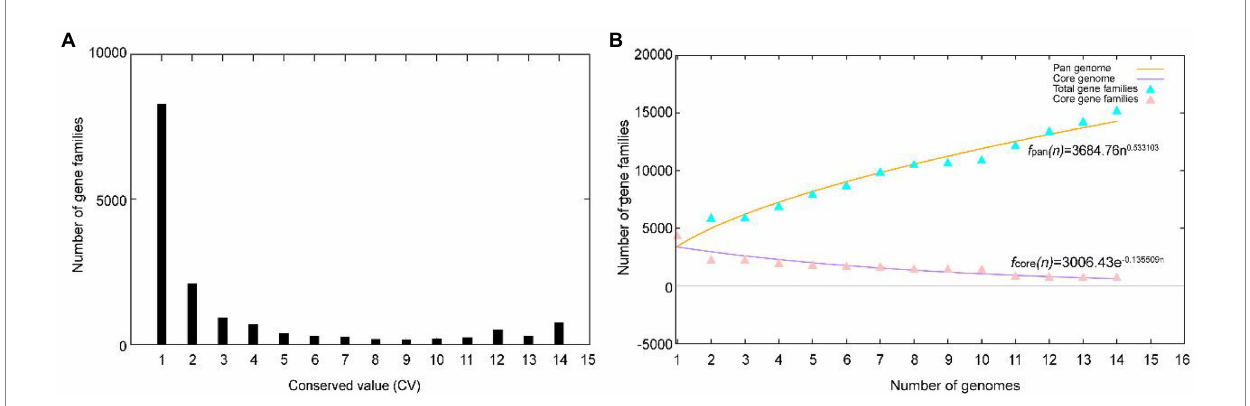
FIGURE 4 Overview of the pan-genomic results generated by BPGA using the 14 genomes of the genus Herbiconiux . (A) The gene family frequency spectrum. (B) The pan genome profile trends of the genus Herbiconiux obtained using clustering tools